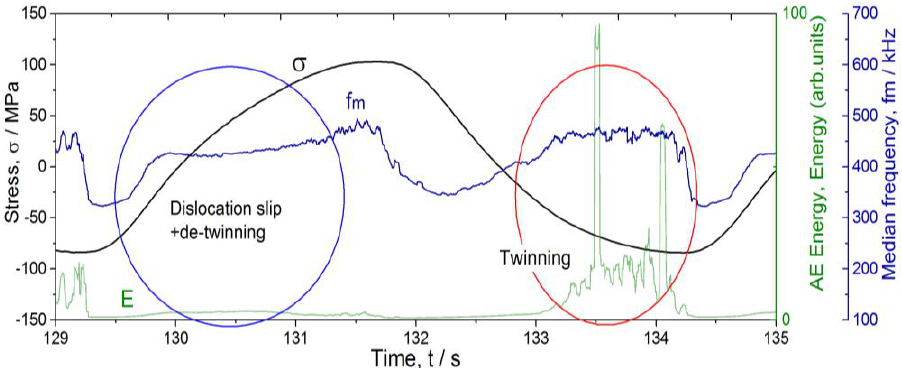
Figure 6. Enraged fragment of the AE behavior reflecting the difference in deformation mechanisms operating in successive tension and compression half-cycles on the mature stage of fatigue of the ZX40 Mg alloy (Mg-4Zn-0.16Ca tested at Δε t /2 = 1 × 10 −2 ). AE signatures corresponding to twins are not seen in tension, but are still discernible in compression. Notice that the scale of the AE energy axis is ten times different from than that in Figures 4 and 5.